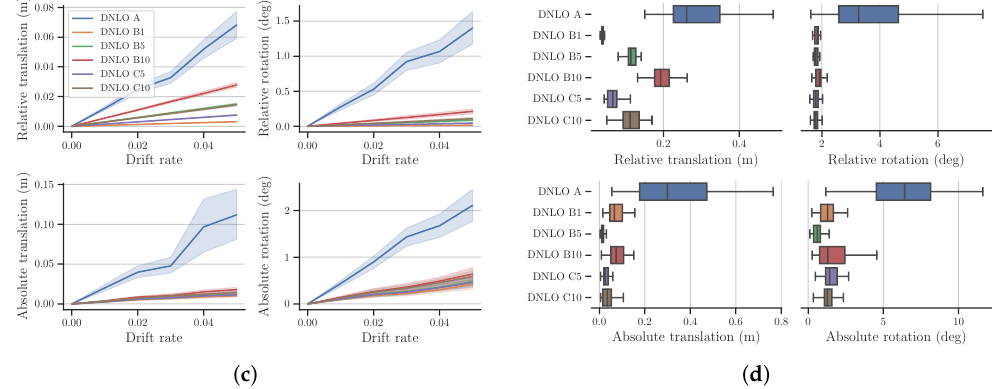
Figure 3. Calibration errors on simulation data for all reference selection methods on DNLO: ( a ) added Gaussian noise, ( b ) added outliers, ( c ) added drift, and ( d ) mixed noise. Plots ( a ) through ( c ) display the mean and 95% confidence intervals, whereas the boxplot ( d ) shows the median and quartiles.